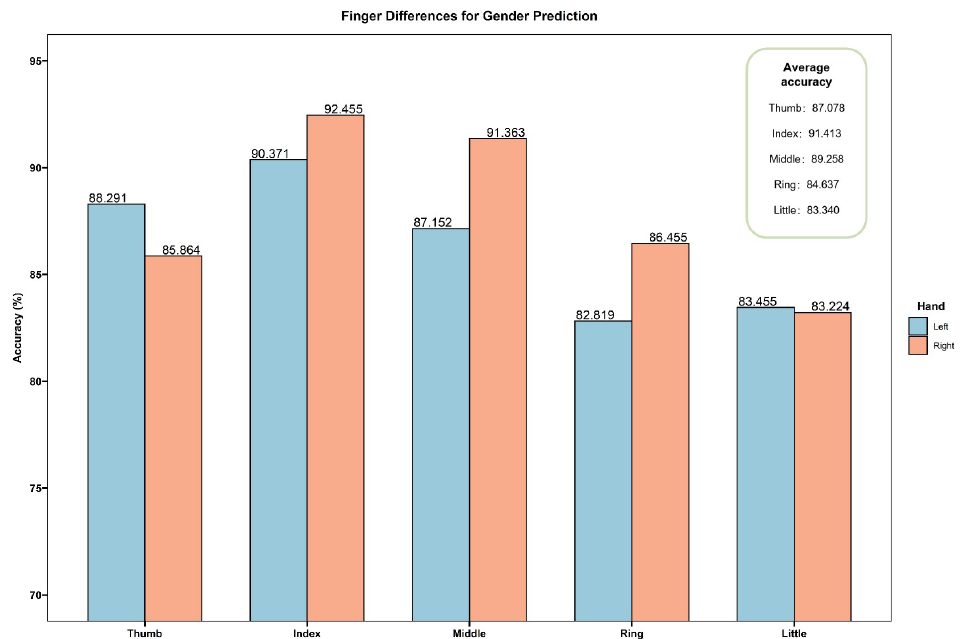
Figure 7. Estimate performance of each finger (%), in which F x represents Finger x . The index from 1 to 5 means little finger, ring finger, middle finger, index finger, and thumb, respectively. In addition, the F average represents the average of their fingers. The highest average accuracy is index finger at 91.413% and the lowest is little finger at 83.340% .